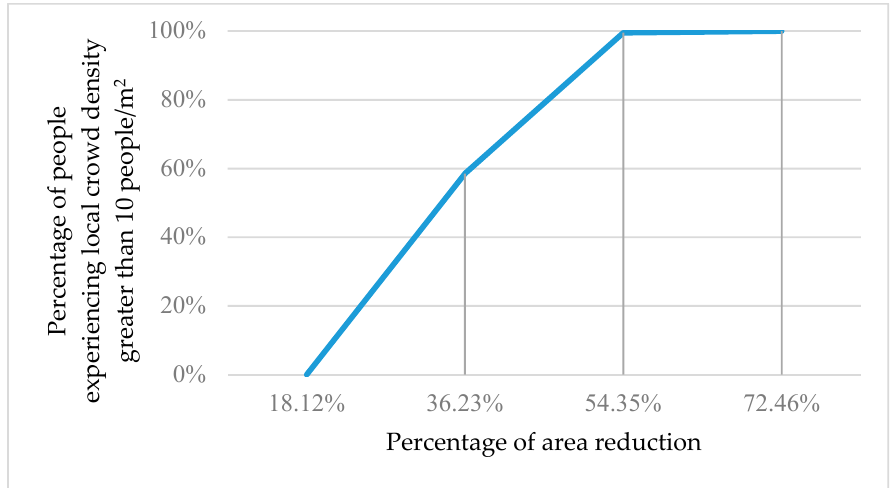
Figure 6. The distribution of local density that the 200 agents experience when the lower wall moves by 0.5 m, 1.0 m, 1.5 m, and 2.0 m to compress the occupied space.